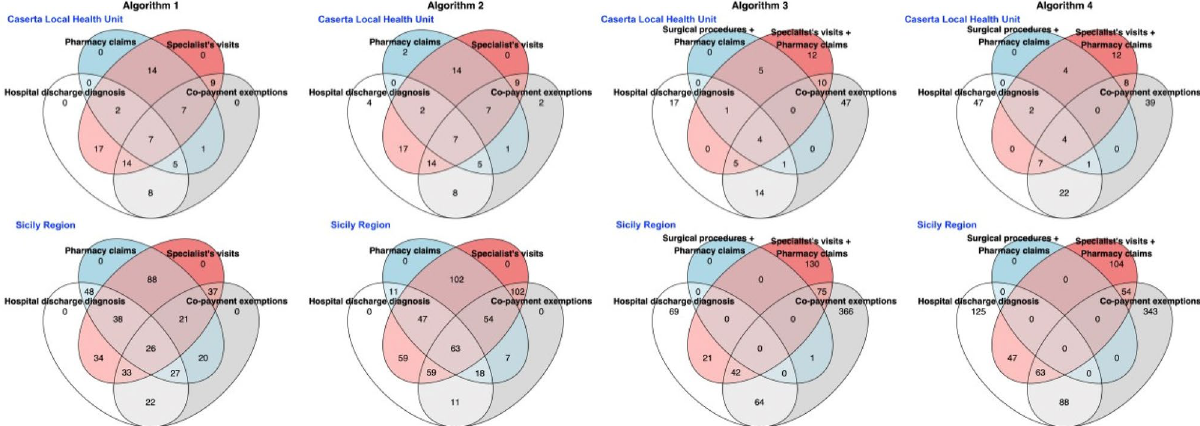
Figure 1. Frequency distribution (Venn diagrams) of the number subjects identified by each proposed algorithm as having acromegaly, with respect to different data sources (i.e. databases of Caserta Local Health Unit and Sicily Region) during the study period.